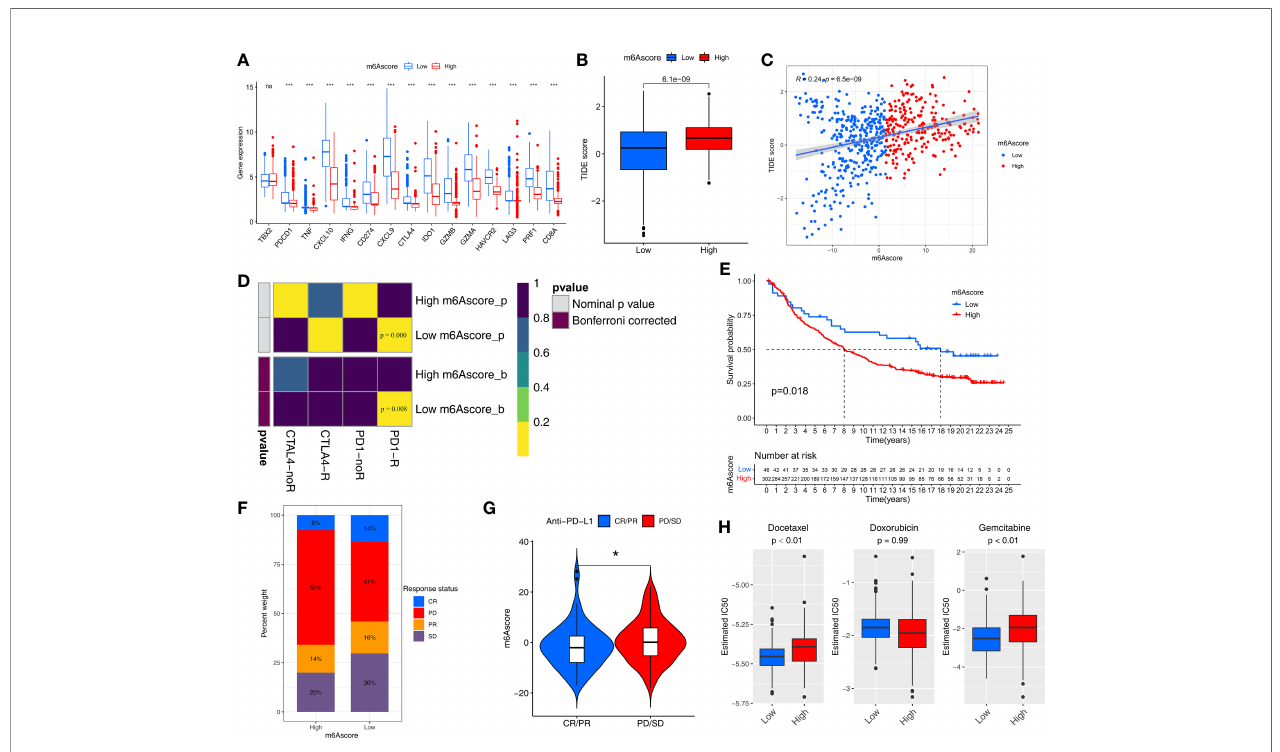
FIGURE 6 | m6Ascore predicts responses to immunotherapy and chemotherapy. (A) Differences in the expression of immune checkpoint genes between the low and high m6Ascore groups in the TCGA-SARC and GSE21050 cohort. The statistical difference of clusters was compared through the Kruskal – Wallis test. *P < 0.05; ***P < 0.001. ns, no signi fi cant. (B) Differences in the TIDE scores between the low and high m6Ascore groups in the TCGA-SARC and GSE21050 cohort. The thick line represents the median value. (C) Scatter plots depicting the positive correlation between TIDEscore and m6Ascore in the TCGA-SARC and GSE21050 cohort by the Spearman correlation analysis. The dotted color indicates the low (blue) and high (red) m6Ascore groups. (D) Submap analysis manifested that low-m6Ascore groups could be more sensitive to the programmed cell death protein 1 inhibitor (Bonferroni-corrected P = 0.008). (E) Kaplan-Meier curves for high and low m6Ascore patient groups in the IMvigor210 cohort. (F) The proportion of patients in the IMvigor210 cohort with clinical response in low or highm6Ascore groups. (G) Violin plot showing differences in the m6Ascore among patients with different clinical responses in the IMvigor210 cohort using Kruskal – Wallis test. The statistical difference of clusters was compared through the Kruskal – Wallis test. *P < 0.05. (H) The box plot of the estimated IC 50 for Docetaxel, Docetaxel and Gemcitabine are shown between the low and high m6Ascore